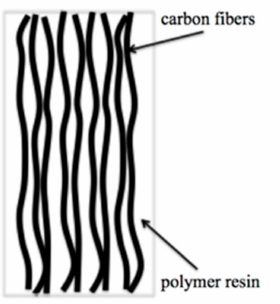
Figure 3. Curving carbon fibers in